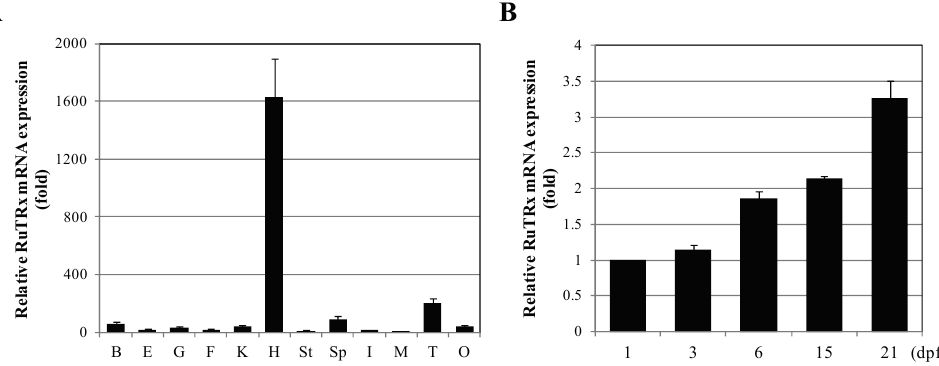
Figure 4. Expression of RuTrx mRNA in various tissues and during early